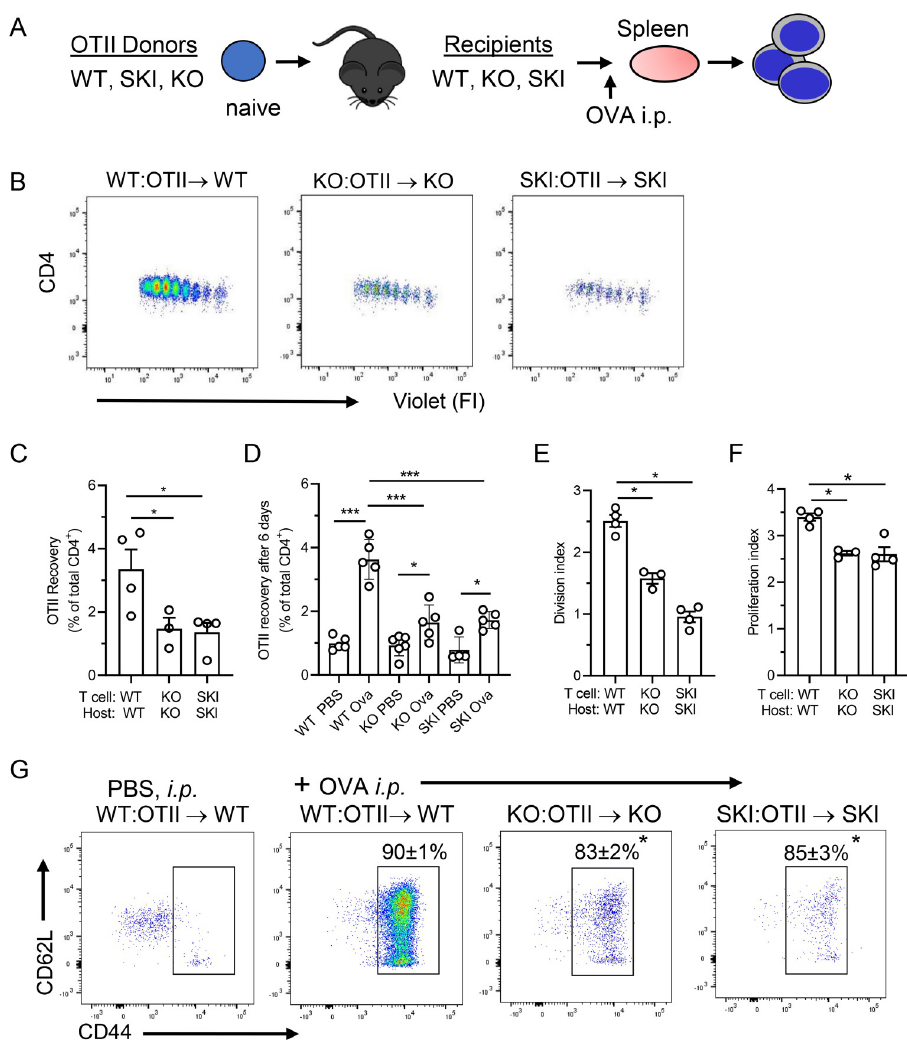
Fig 1. Interaction of CD47 with its ligand SIRP α is necessary for Ag-induced CD4 + T cell expansion in vivo. (A) T cell adoptive transfer scheme. (B) Proliferation of adoptively transferred violet dye labeled CD4 + OTII T cells recovered from WT, Cd47 KO or SKI recipient mice. Each peak indicates one cell division. (C-F) OTI cells recovered after 72 h or 6 days, and division and proliferation indices of transferred OTII T cells post OVA immunization. Means ± SEM, 4–6 animals per group, and representative of 2 independent experiments. � p < 0.05, ��� p < 0.001 compared to WT by one-way ANOVA with Tukey test. (G) Representative CD62L and CD44 surface expression on gated double positive CD4 + WT, Cd47 KO and SKI OTII T cells recovered from spleens of SKI, Cd47 KO or WT mice. The number above the open rectangle is the average percentage of CD44 hi effector T cells. Data are means ± SEM from 3–4 mice per group. � p < 0.05 compared to WT-OVA by one-way ANOVA with Tukey